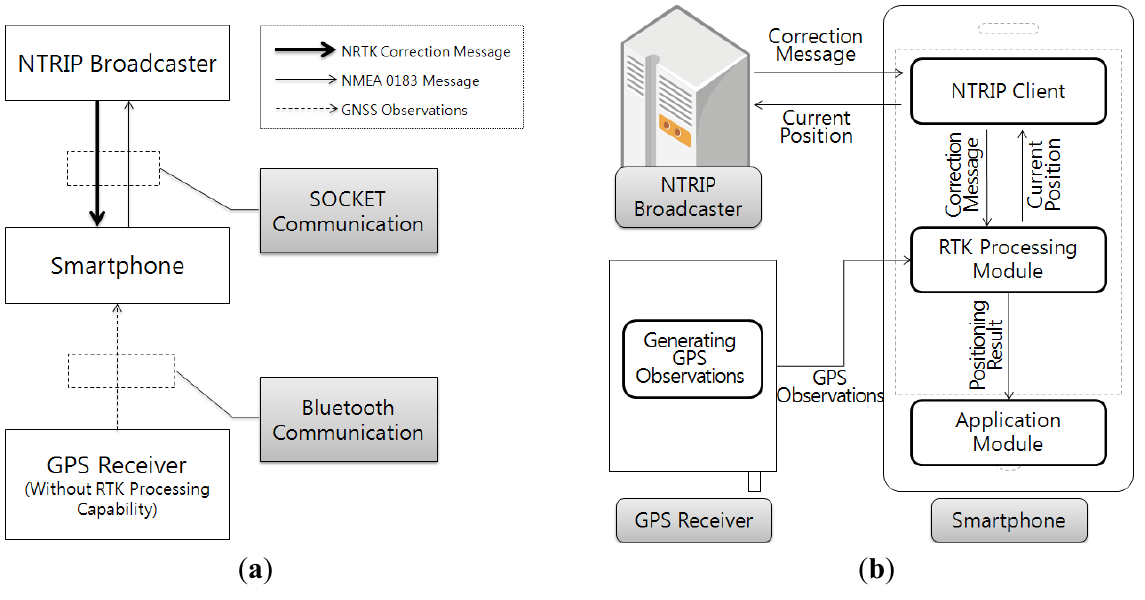
Figure 2. Design plan of the NRTK application for smartphones when use the expensive GPS receiver supporting the RTK function. ( a ) Communication method and data flow. ( b ) Composition of NRTK application and data